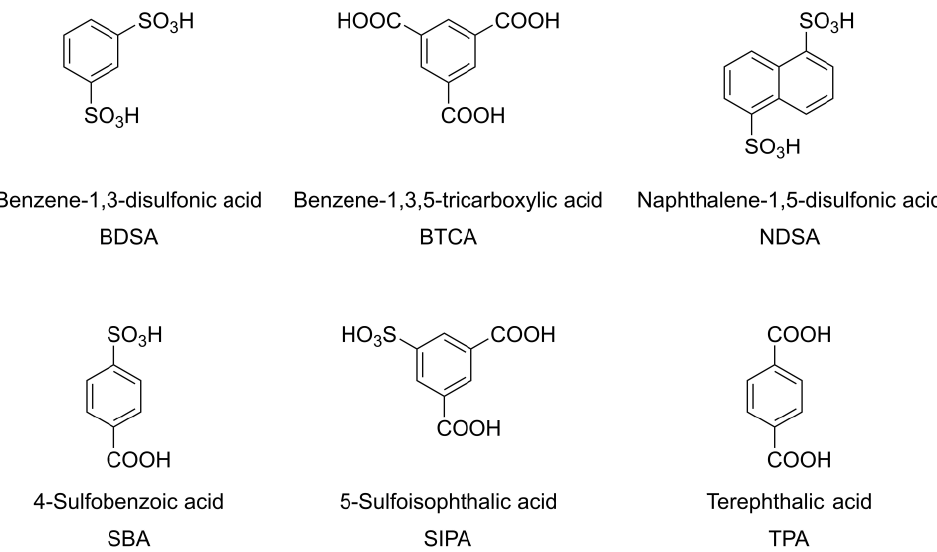
Figure 4. Structures of candidate compounds potentially useful as internal standards: benzene-1,3- disulfonic acid (BDSA), benzene-1,3,5-tricarboxylic acid (BTCA), naphthalene-1,5-disulfonic acid (NDSA), 4-sulfobenzoic acid (SBA), 5-sulfoisophthalic acid (SIPA), and terephthalic acid (TPA).